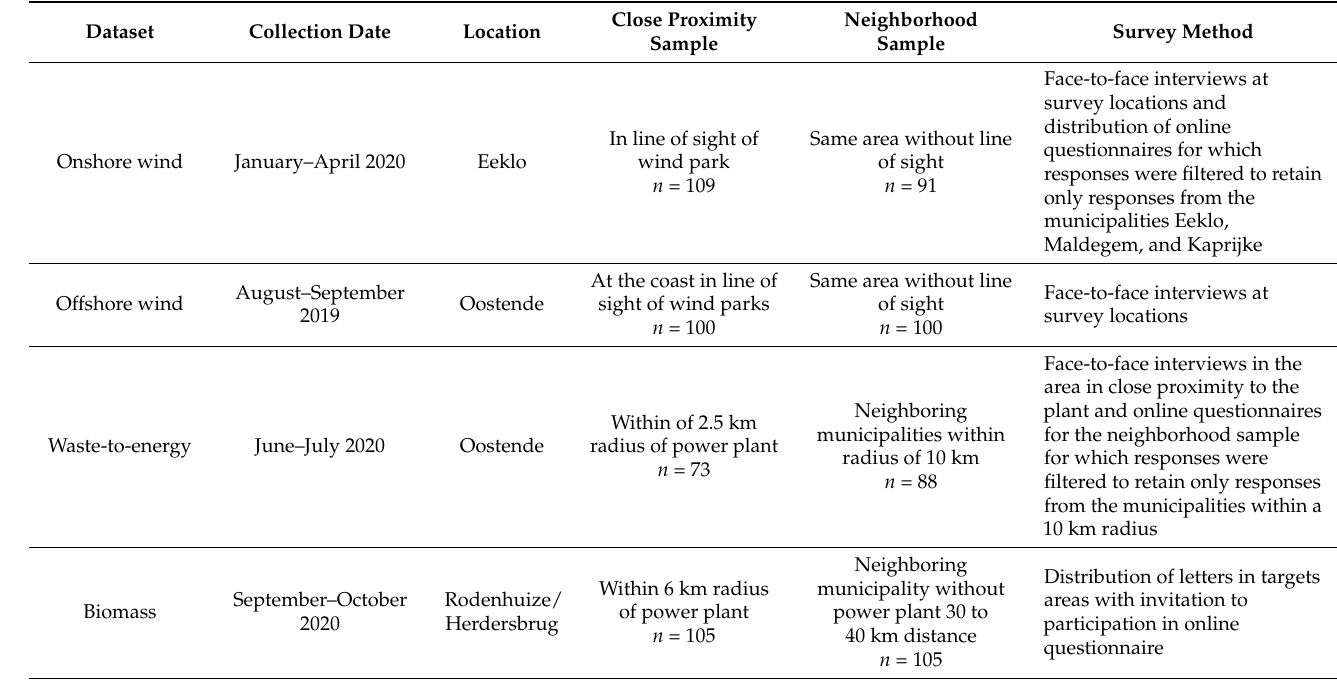
Table 1. Sample characteristics for the four case study